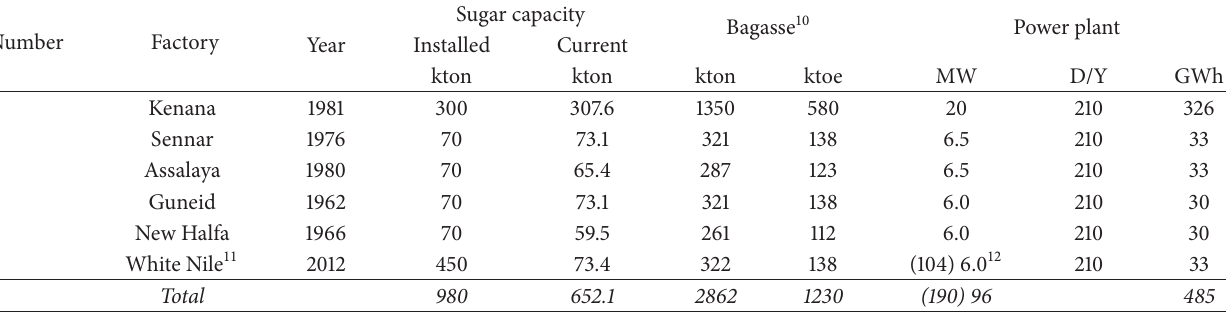
Table 6: Sugar industry power plant [12].